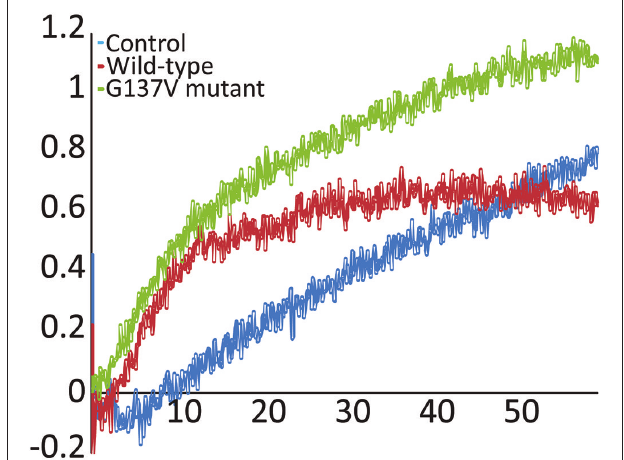
FIGURE 5 | In vitro enzymatic reconstitution of iron sulfur clusters . Absorption spectra were recorded as a function of time in the absence of frataxin and in the presence of wild-type frataxin or the mutants G137V and W155R. The experiments were carried out using 50 µ M IscU, 25 µ M iron, 250 µ M cysteine, 3 mM DTT and 1 µ M Nfs1. When present, the frataxin concentration was 50 µ M. Only the initial rates were monitored and compared to the control.